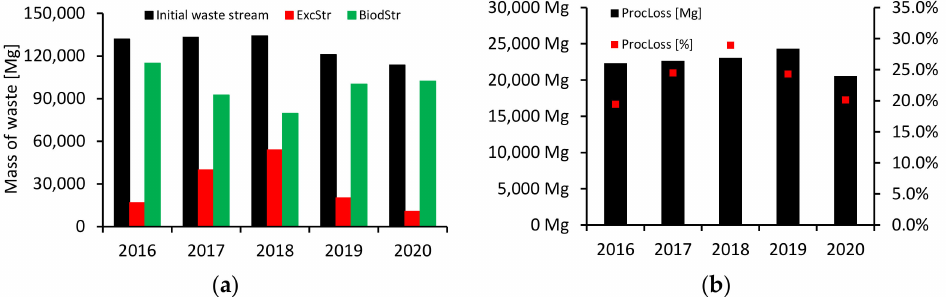
Figure 4. Characteristics of mixed municipal waste stream accepted at the Municipal Waste Management Plant in Olsztyn; ( a ) input stream components; ( b ) process loss resulting from the biodrying